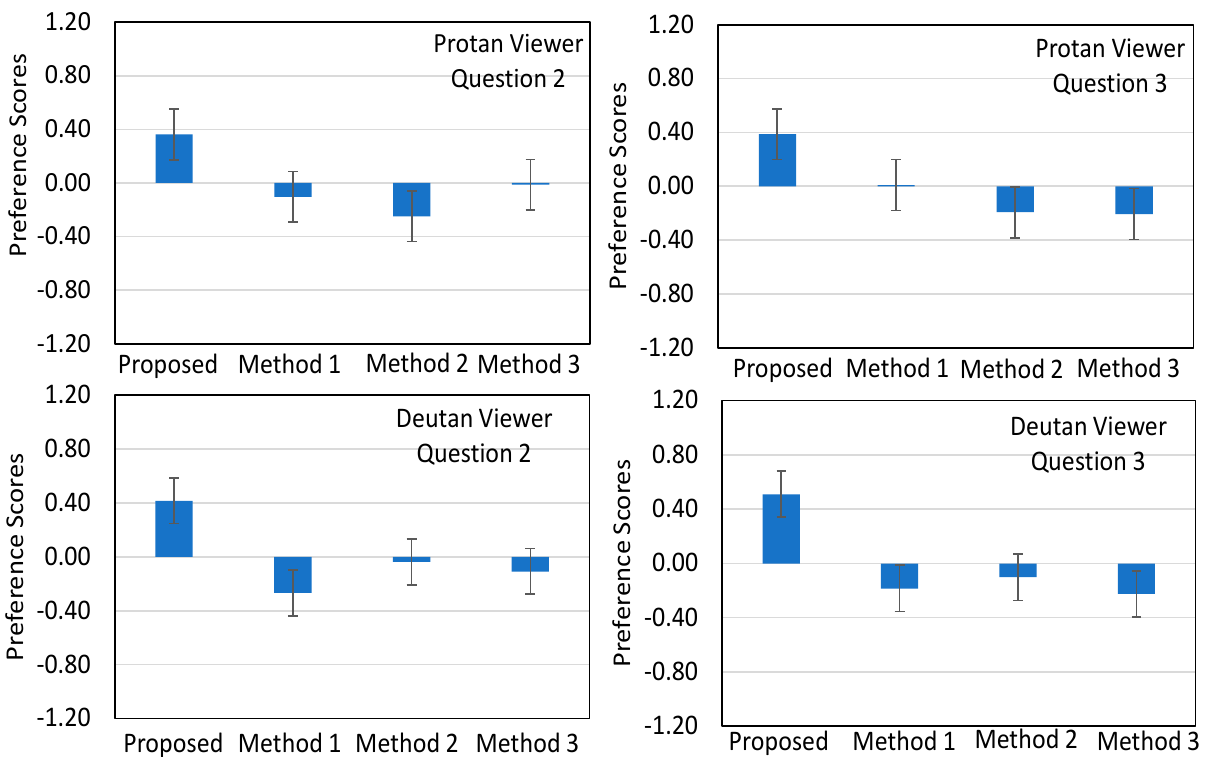
Figure 12. Average preference scores (blue column bars) and the corresponding 95% confidence intervals (error bars) of the pairwise comparisons for the participants belonging to Group 2 and 3: ( first raw ) reports the results for the protan viewers regarding the protanopia recolored images and the questions 2 and 3, and ( second raw ) reports the results for the deutan viewers regarding the deuteranopia recolored paintings and the questions 2 and 3.